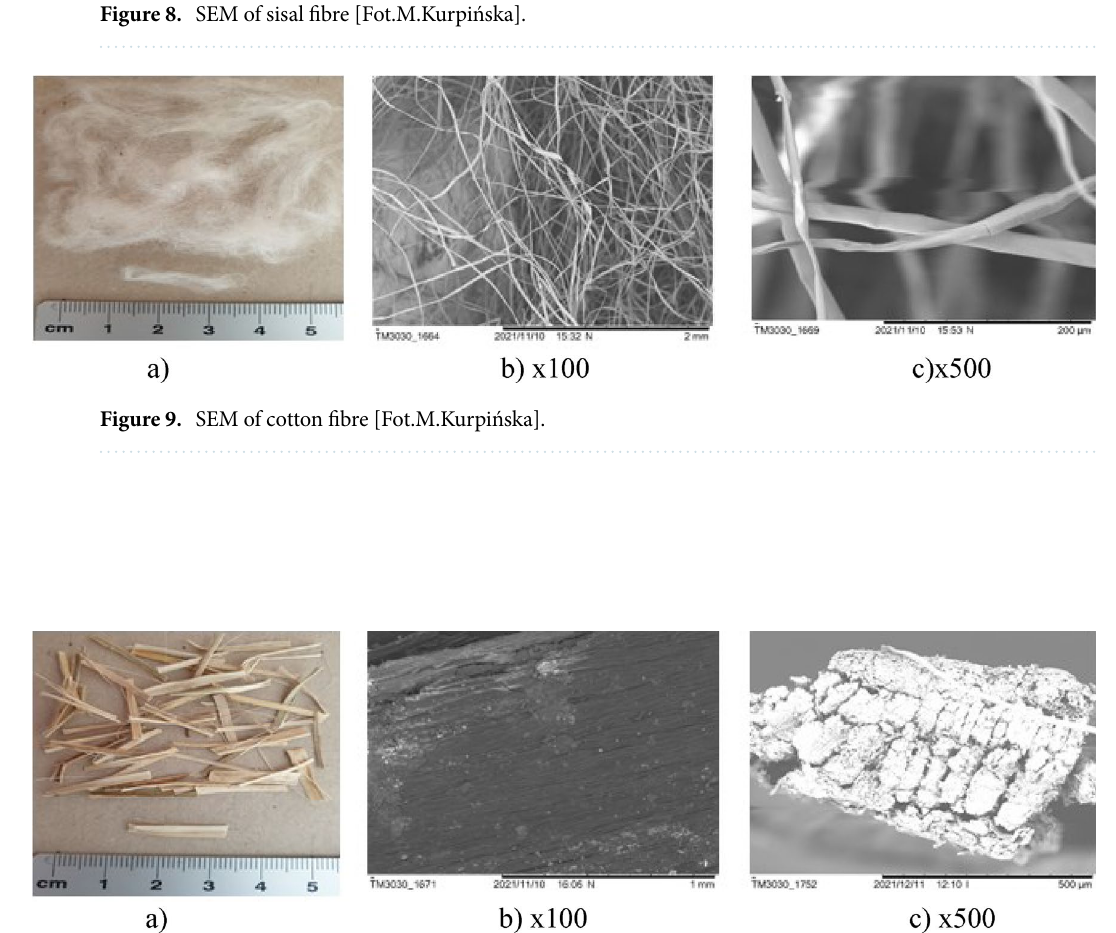
Figure 10. SEM of ramie fibre